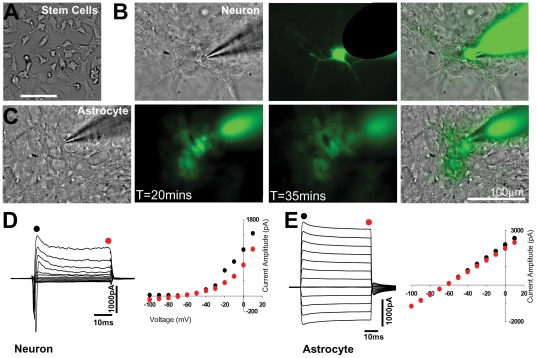
Distinct functional properties of NT2 neurons and astrocytes.
A. DIC image of undifferentiated NT2 stem cells displaying undifferentiated morphology. B. Leftmost panel shows DIC image of a patched neuron in a cluster. Central image shows the same cell excited at 488 nm to reveal neuronal morphology from the patch pipette filling by Alexa 488. Rightmost panel superimposes the green and DIC channels, illustrating the pathway of the neuron's processes within and efferent from the cluster. C. Leftmost panel shows DIC image of a patched astrocyte, image to right shows a fluorescent image of the field taken 20 minutes after patch clamping an astrocyte with Alexa 488 containing pipette. Many astrocytes can be seen to be filled, and displaying a “tile-like" morphology. Middle panel shows an image taken 15 minutes later illustrating further spread of the Alexa 488 dye. Righmost panel superimposes the green and DIC channels. D. Current responses elicited by voltage steps in a patch clamped neuron. Depolarisations elicit a transient inward current and sustained inactivating outward current. The maximal and steady state amplitude of the outward component (Black and Red symbols respectively) are plotted to the right illustrating an outwardly rectifying nature. E. Current responses in an astrocyte elicited by voltage steps, displaying lack of transient components. The plot of instantaneous and steady state current reveal a linear I–V relation. Cells were used within 14 days of differentiation.